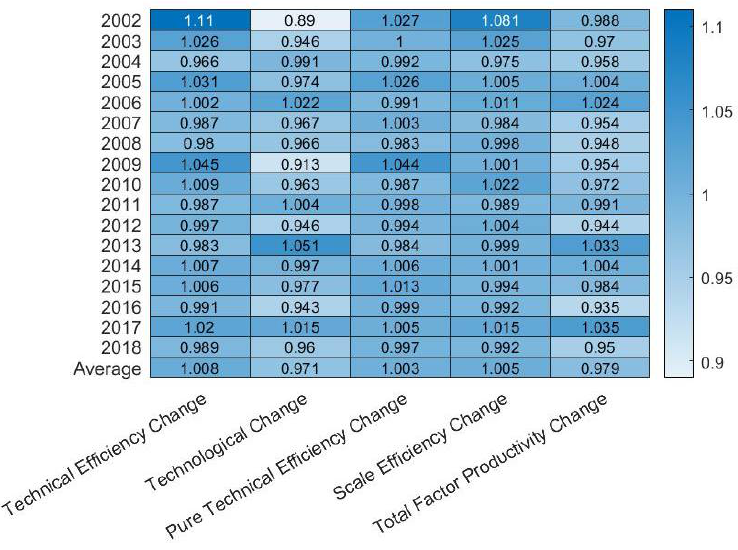
Figure 8. Geometric mean of the overall annual MPIs.